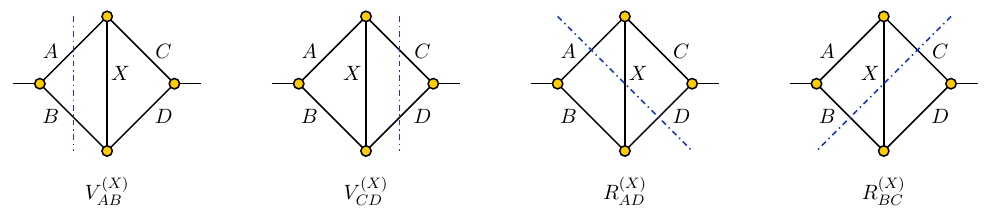
Figure 1 . Diagrams contributing to one-loop two-body decay (the first two diagrams with the cut that encounters two particle lines) and three-body decay (the last two diagrams with the cut that encounters three particle